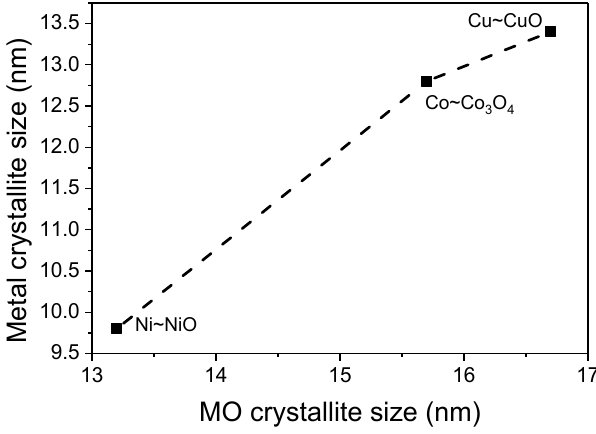
Figure 2. The dependence of metal crystallite sizes on those of metal oxides.